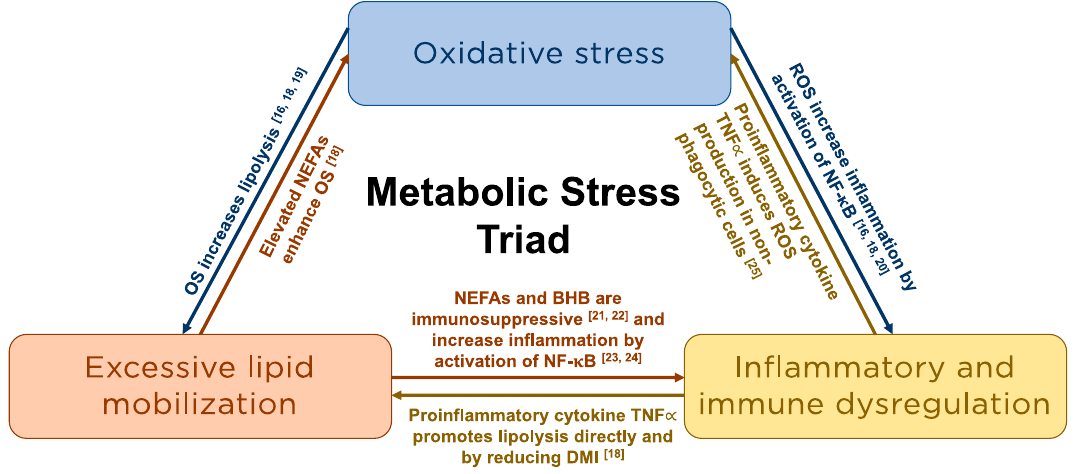
Figure 1. Schematic representation of the intrinsic relationships among the components of the metabolic stress triad. NEFA = non-esterified fatty acid; OS = Oxidative Stress; ROS = Reactive oxygen species; NF- κ B = nuclear factor kappa-B; BHB = beta-hydroxybutyrate; TNF α = Tumor necrosis factor alpha; DMI = Dry matter